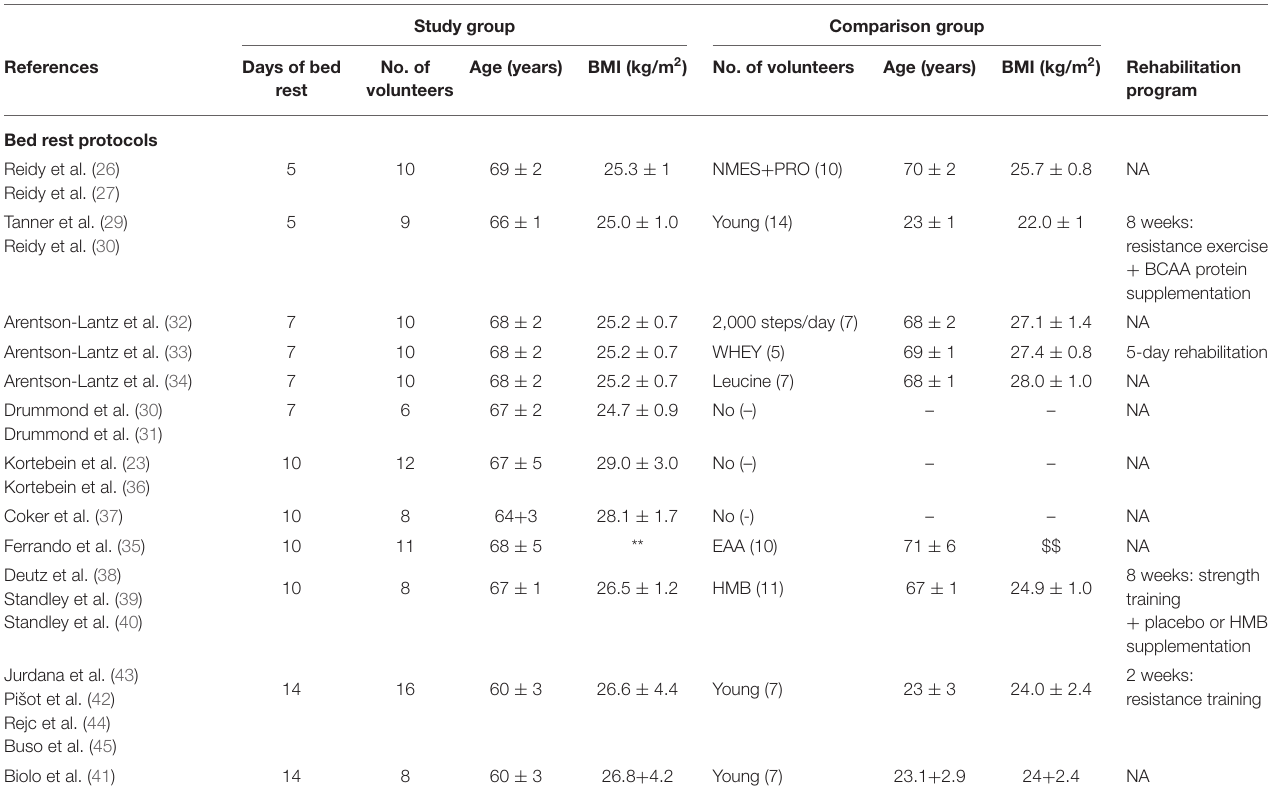
TABLE 1 | Experimental bed rest protocols involving healthy elderly